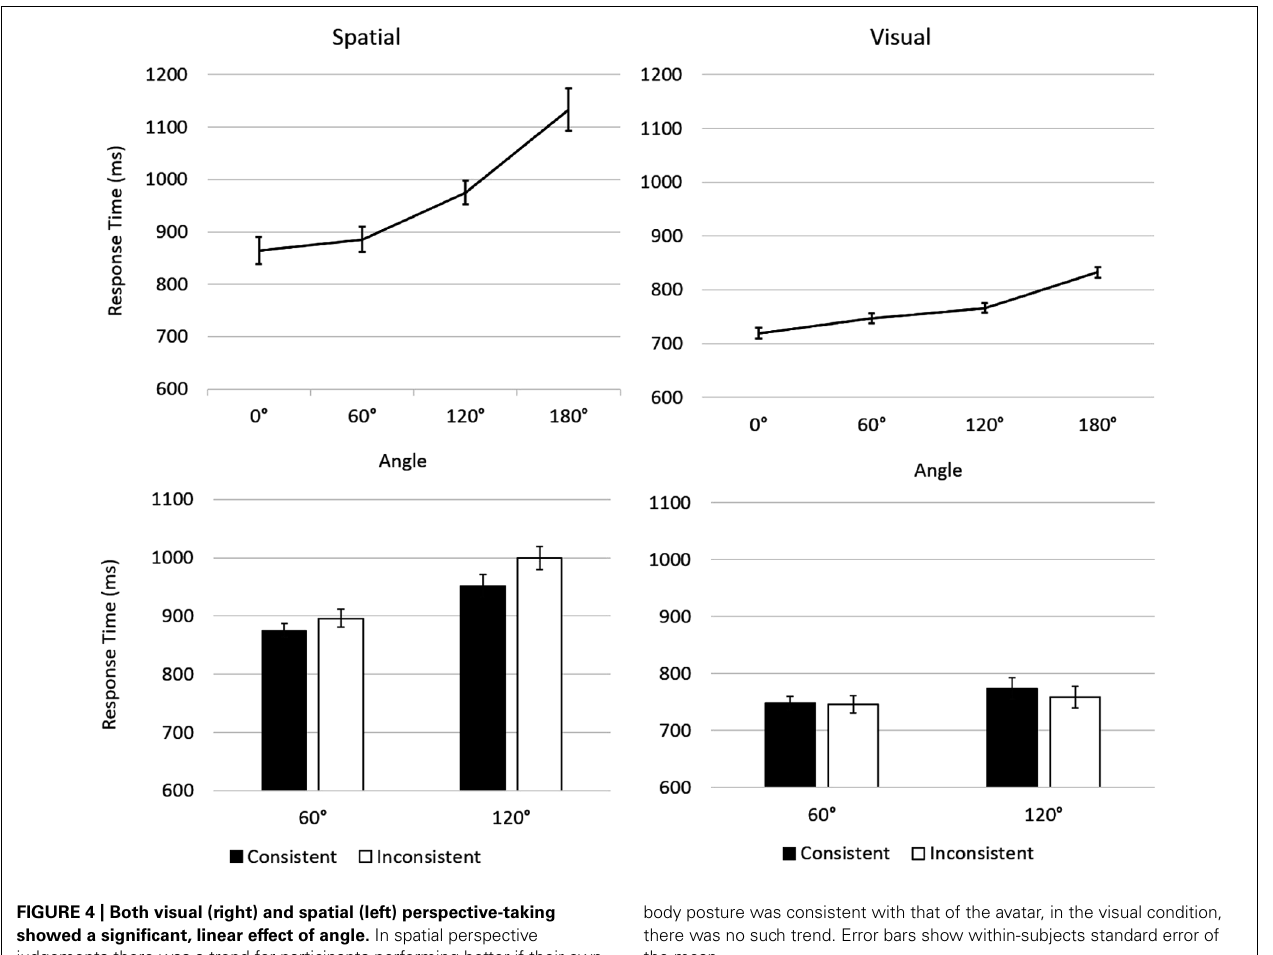
FIGURE 4 | Both visual (right) and spatial (left) perspective-taking showed a significant, linear effect of angle. In spatial perspective judgements there was a trend for participants performing better if their own